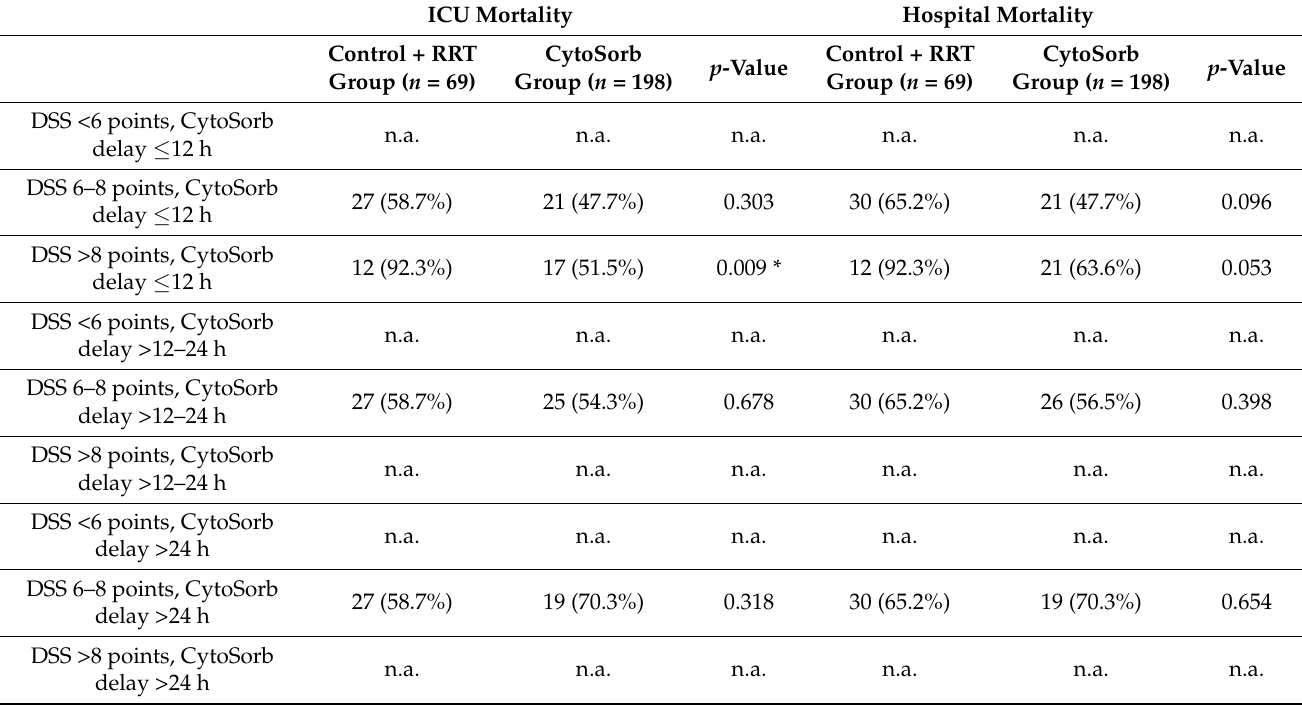
Table 6. Association between DSS score, therapy delay and outcome between control + RRT vs. CytoSorb group. Please note that groups containing not enough patients for a reliable statistical evaluation were classified as not applicable (n.a.); therefore, no analysis was performed in these groups. Presented are frequency and percentage (%) and levels of